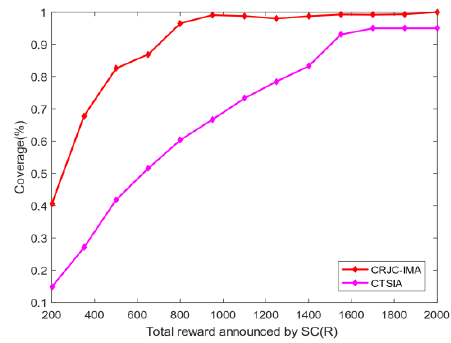
Figure 4. Change of coverage and total reward.